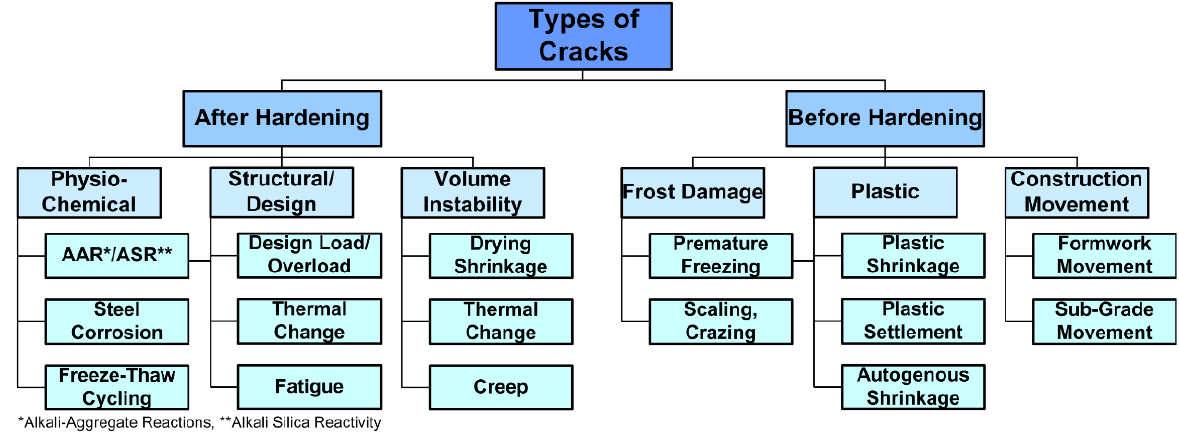
Figure 3. Common causes for cracking in concrete structures (according to [119]).